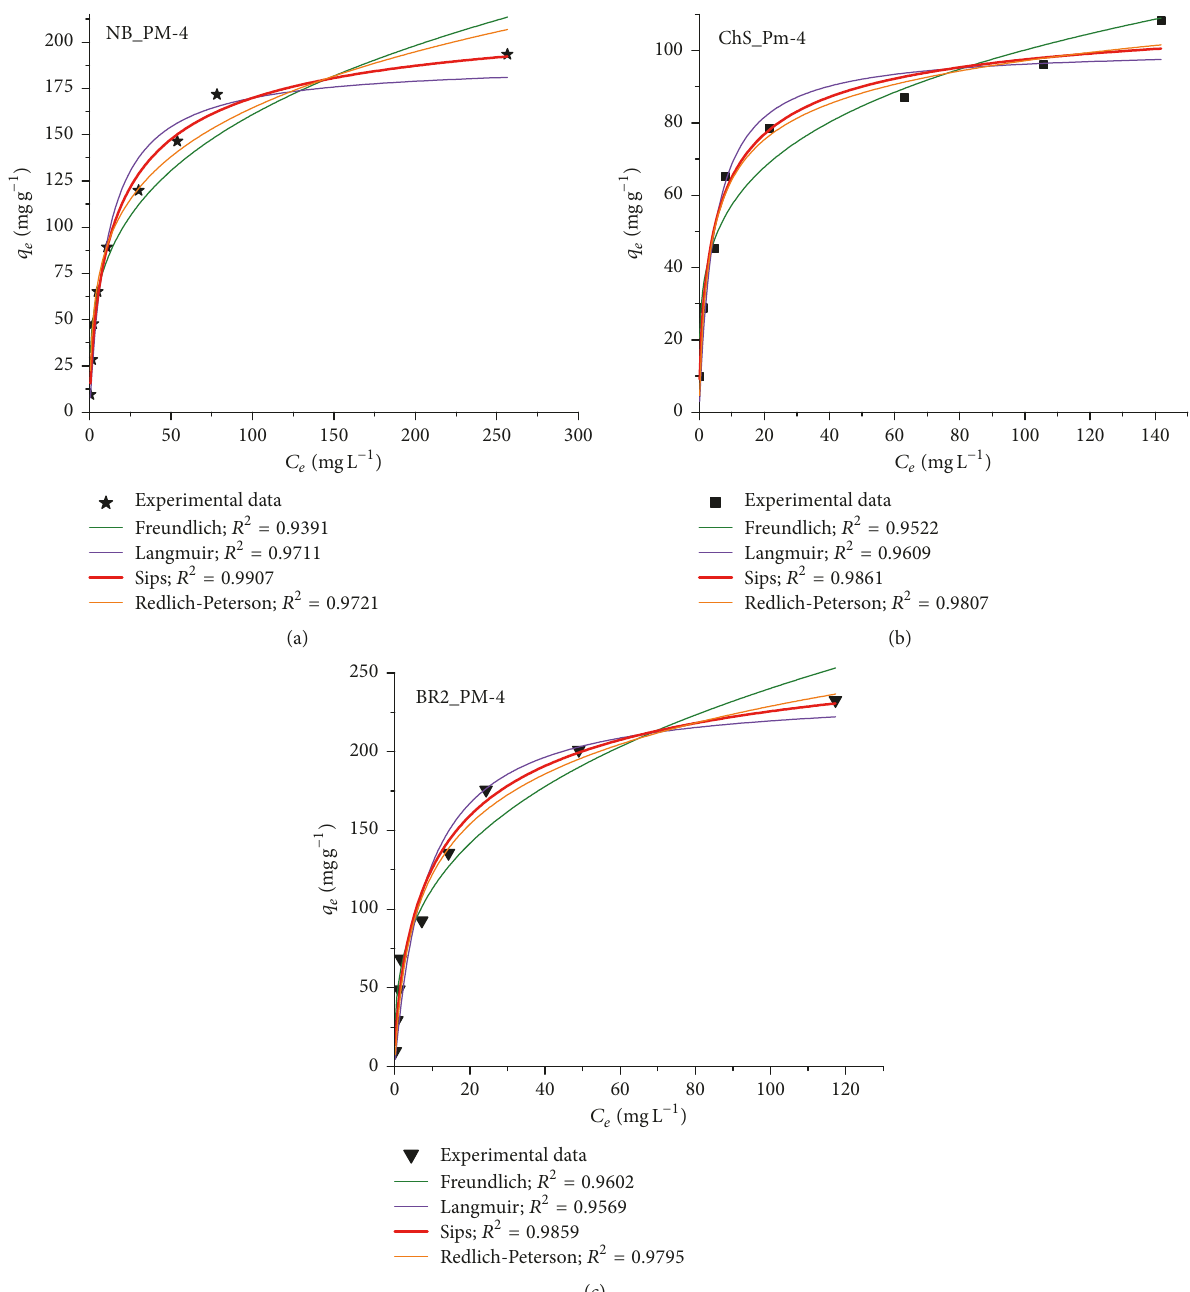
Figure 8: Isotherms plots for the adsorption of (a) NB, (b) ChS, and (c) BR2 on PM-4.